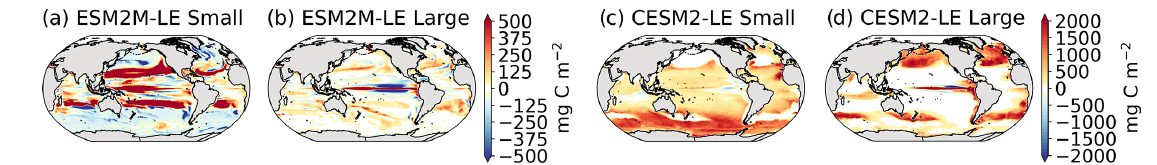
Figure B10. Difference between the integrated biomass change (cid:49)n (Fig. 5e–h) and the NPP − Loss contribution to (cid:49)n (Fig. 5i–l). This residual term includes the circulation contribution to (cid:49)n and all errors inherent to the decomposition in Eq. (8).